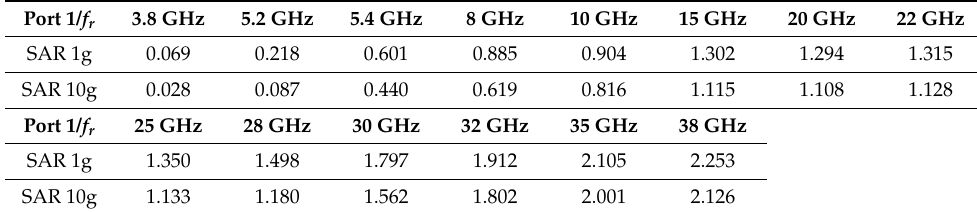
Table 7. SAR values (W/kg) on arm at different frequencies.